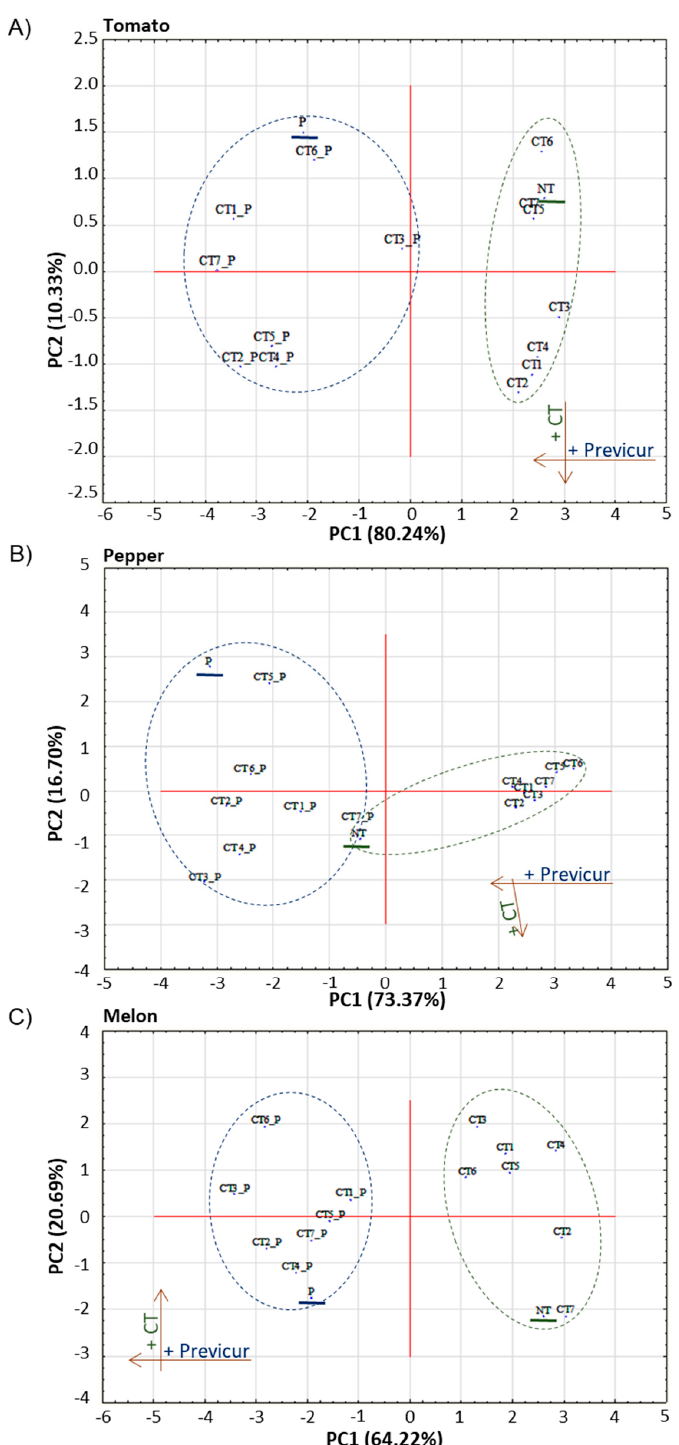
Figure 2. Principal component analysis score-plot distribution of nursery treatments on tomato ( A ), pepper ( B ), and melon ( C ) on the base of the assessed biometric plant traits, along the axes of principal component 1 (PC1) and 2 (PC2) describing percentages of the total data variability indicated in brackets. Cases are referred to CT treatments followed by Previcur Energy (CT1–7_P, grouped in blue circles), CT treatments alone (CT1–7, grouped in green circles), and the two controls Previcur Energy alone (P, underlined) and none-treatments (NT, underlined). Moreover, arrows show how the indicated Previcur Energy and CT treatments putatively affected the separation of the cases along the plot.